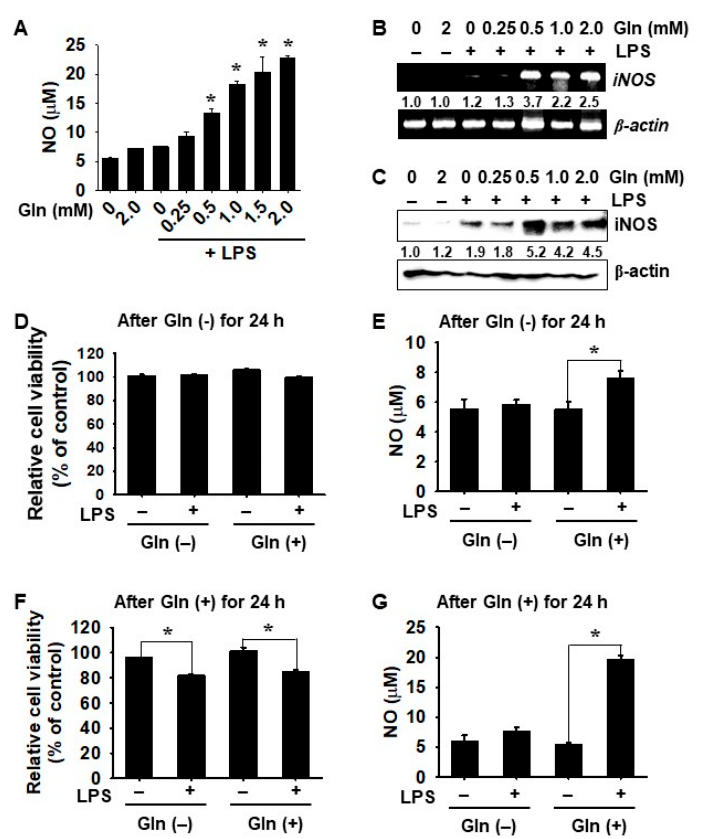
Figure 2. Gln-free condition downregulates lipopolysaccharide (LPS)-induced inducible nitric oxide synthase ( iNOS ) expression and nitric oxide (NO) production in BV2 microglial cells. ( A – C ) BV2 microglial cells (1 × 10 5 cells / mL) were incubated with 2.0 mM Gln for 24 h, the media were then replaced with fresh media containing the indicated concentrations of Gln, 2 h before treatment with 500 ng / mL LPS. ( A ) The amount of NO were determined by the Griess reaction at 24 h and a standard curve was constructed using NaNO 2 . ( B ) In a parallel experiment, total mRNA was extracted at 6 h and RT-PCR for iNOS was performed. ( C ) Protein lysates were extracted at 24 h and then resolved on SDS-polyacrylamide gels. The protein was transferred to nitrocellulose membranes and probed with antibodies against iNOS. β -Actin was used as an internal control for RT–PCR and western blotting. Densitometry value of iNOS was compared to the β -actin levels in RT–PCR and western blotting; shown in the bottom. ( D , E ) BV2 microglial cells were cultured in Gln-free media for 24 h, and the media were replaced with Gln-free or 2.0 mM Gln-containing media, 2 h before treatment with 500 ng / mL LPS for another 24 h. ( D ) Cell viability was measured by MTT assay and ( E ) NO production was detected by the Griess reaction. ( F , G ) BV2 microglial cells were cultured in 2.0 mM Gln-containing media for 24 h, and the media were then replaced with Gln-free or 2.0 mM Gln-containing media for another 24 h after stimulation of 500 ng / mL LPS. ( F ) Cell viability was measured by the MTT assay and ( G ) NO production was detected by the Griess reaction. The results are the average of three independent experiments and are expressed as mean ± standard error of the median (* p <